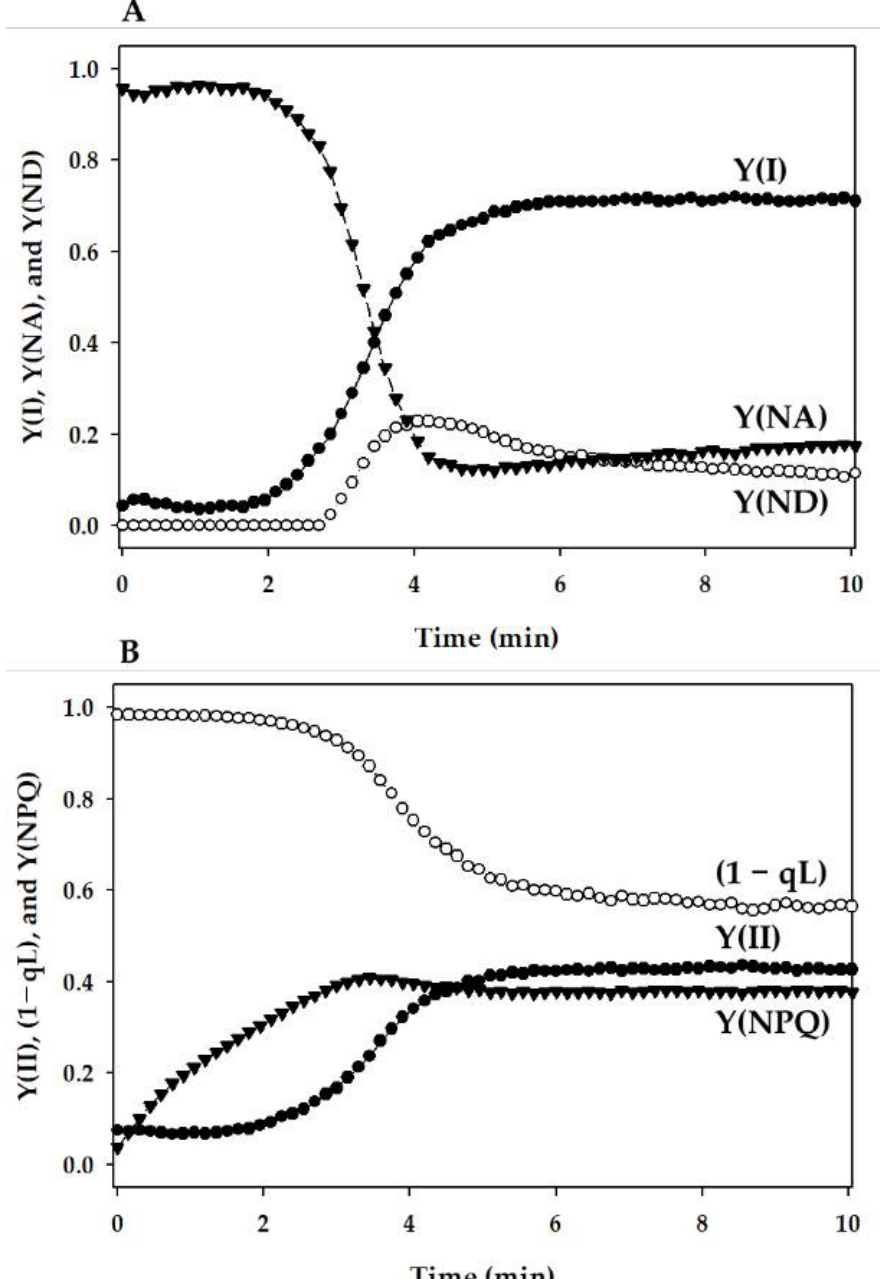
Figure 1. Induction of photosynthesis parameters for photosystems I (PSI) and II (PSII) of the intact leaves of the sunflower plants ( Helianthus annuus ). ( A ) PSI parameters: Y(I), Y(NA), and Y(ND) were plotted against the actinic light (AL) illumination time. ( B ) PSII parameters: Y(II), Y(NPQ), and (1 − qL) were plotted against the AL illumination time. The leaves were illuminated with AL of 1000 µmol photons m −2 s −1 in the presence of 1% CO 2 and 20% O 2 in the chamber (25 °C). AL was turned on at 0 min. Each data set presented is a typical representation.